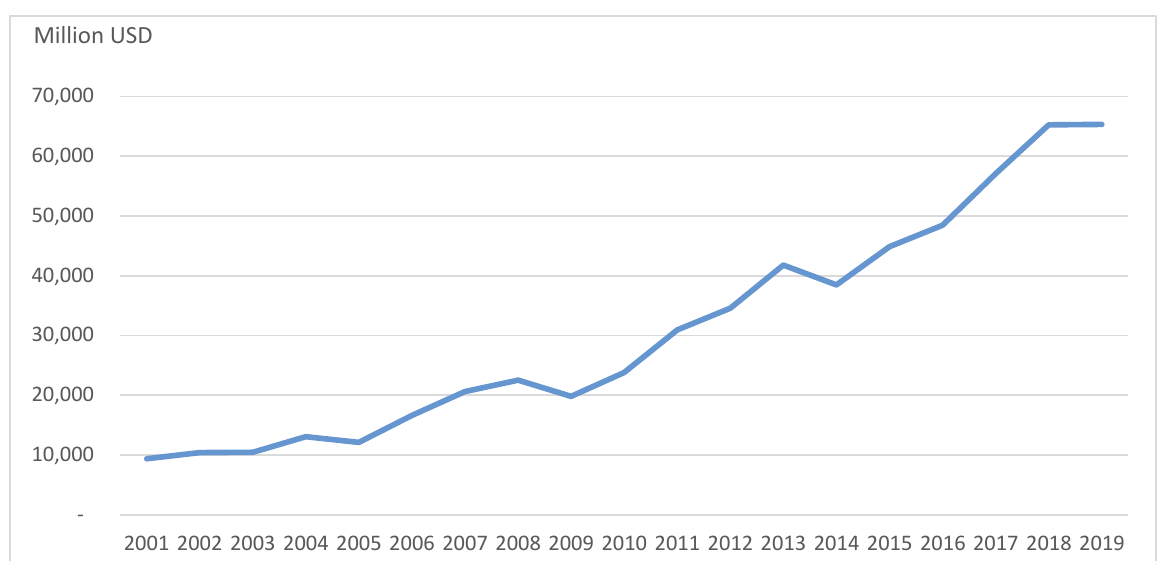
Fig. 1. Number of Foreign Tourists Visiting Thailand 2001-2019